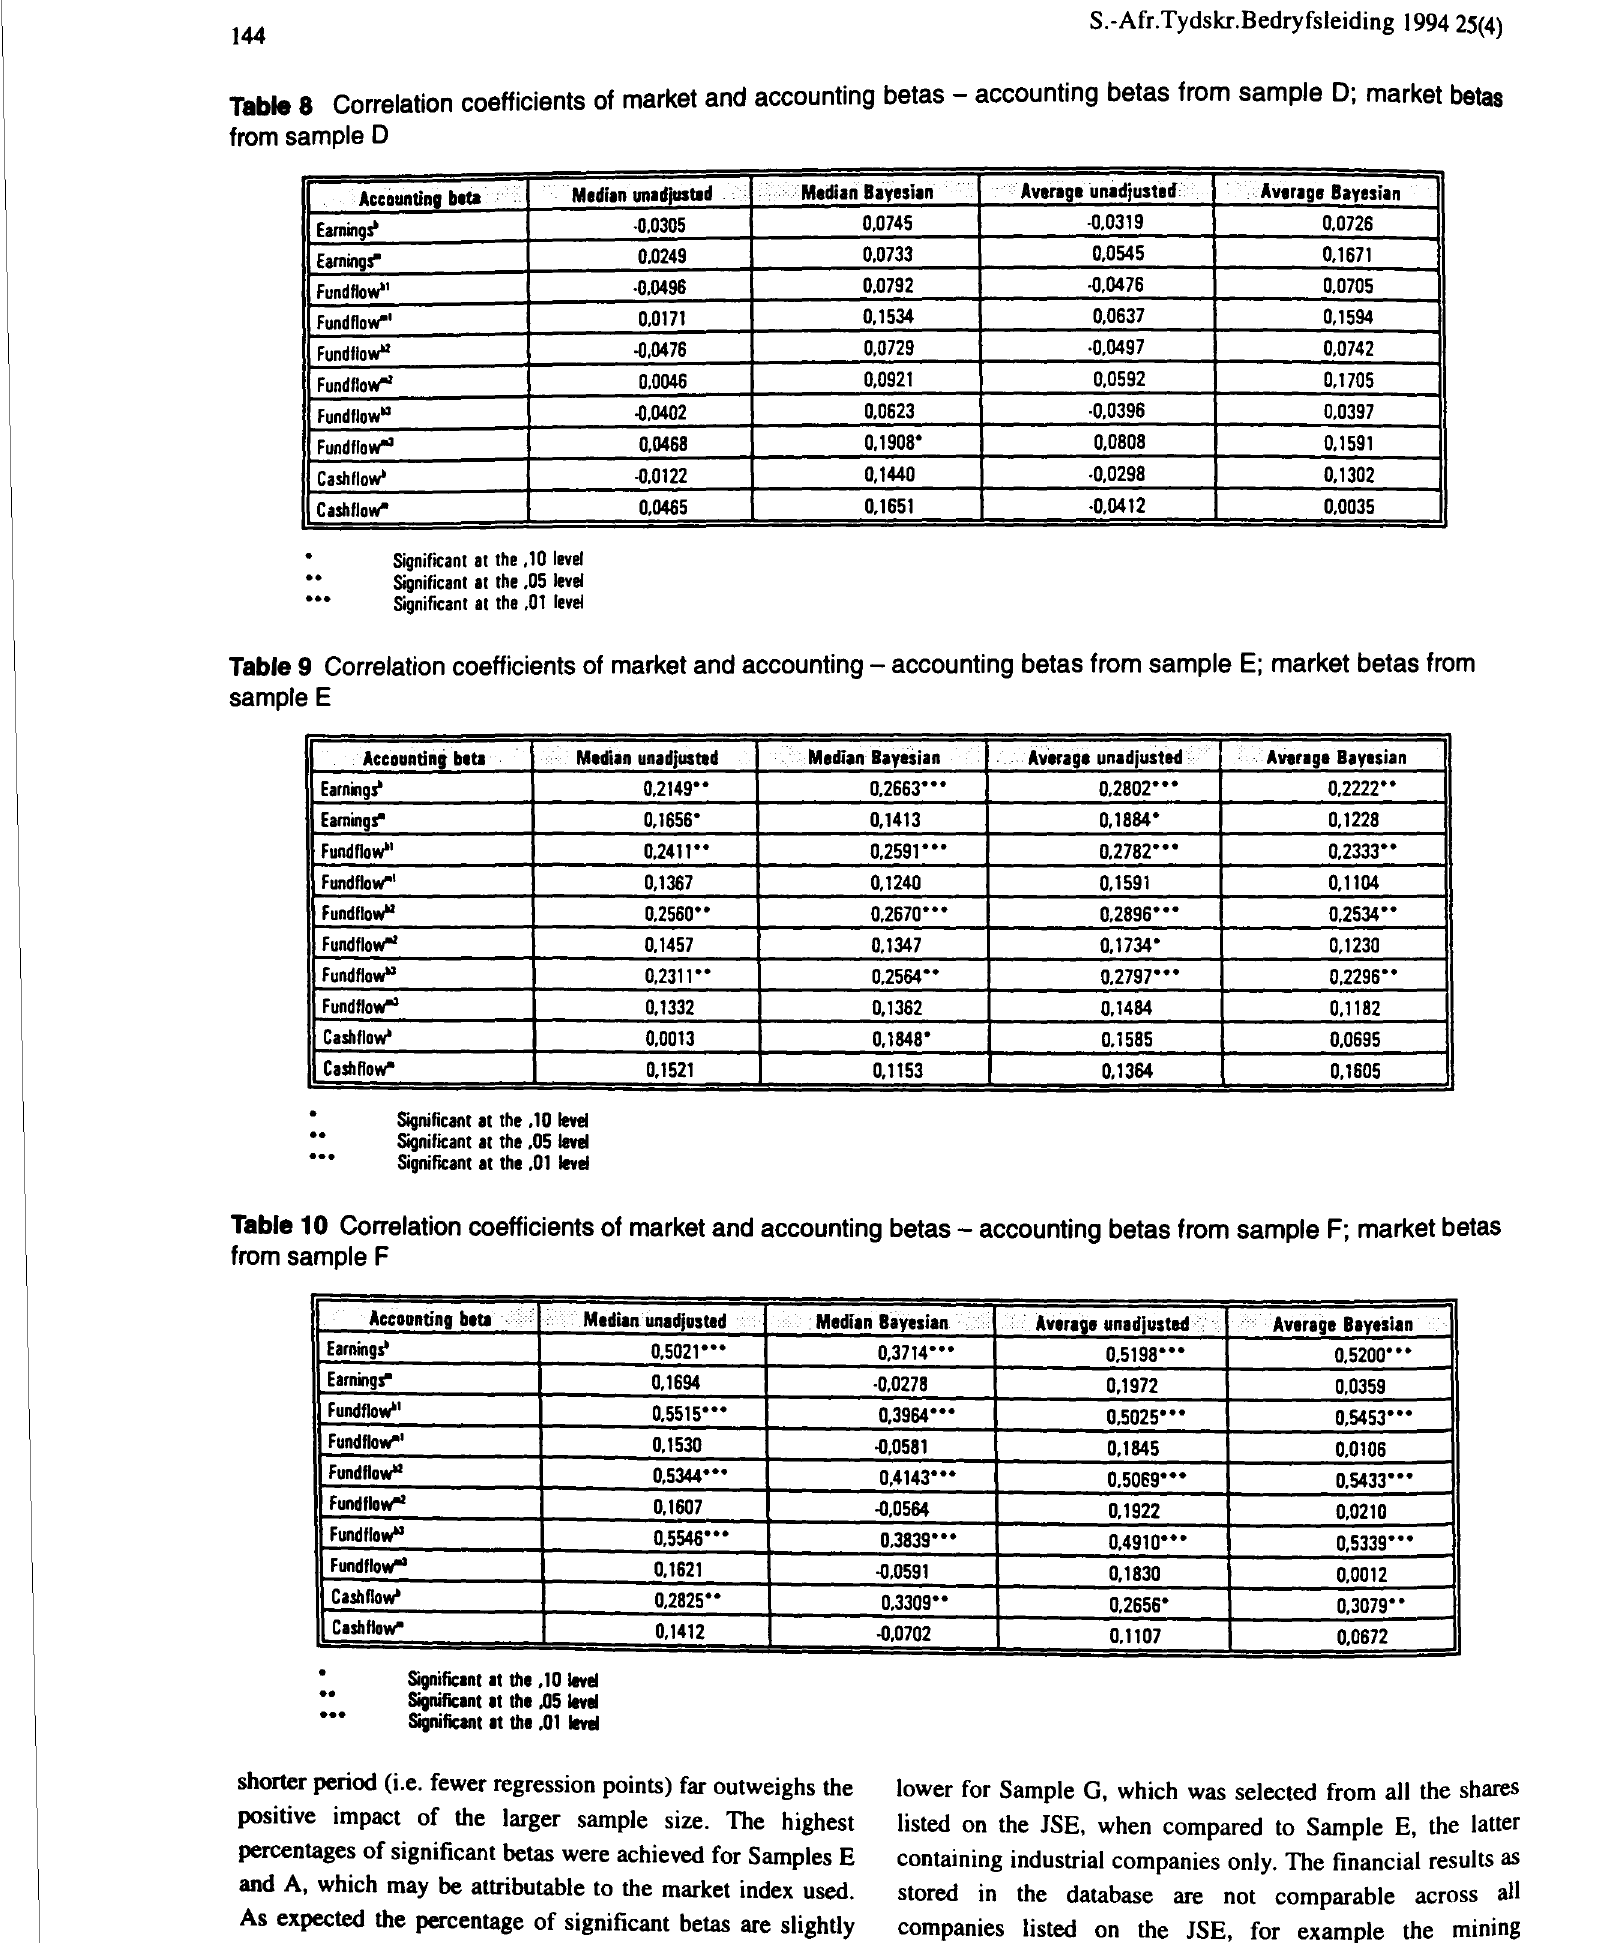
Table 8 Correlation coefficients of market and accounting betas - accounting betas from sample D; market betas from sample D